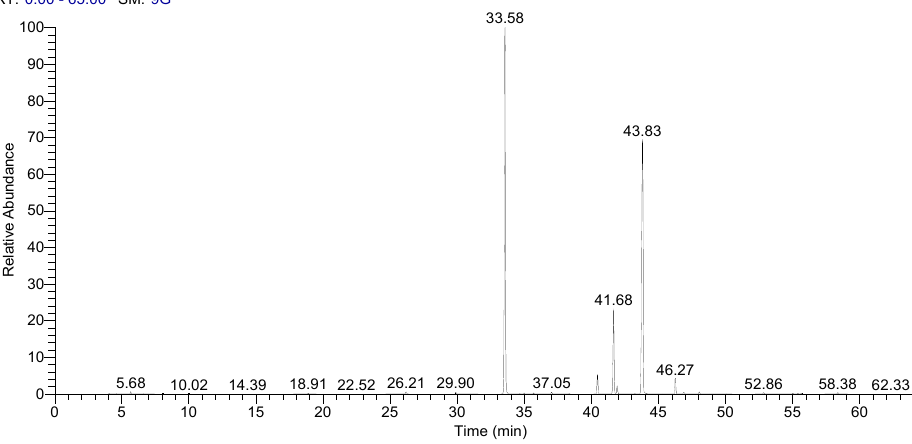
Figure 4. Spectra of GC–MS for fatty acid methyl esters of whole wheat.